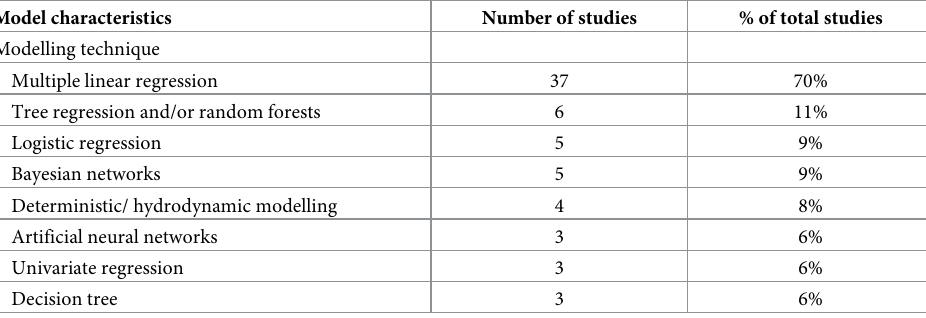
Table 2. Modelling techniques for creating the predictive models present in 53 relevant